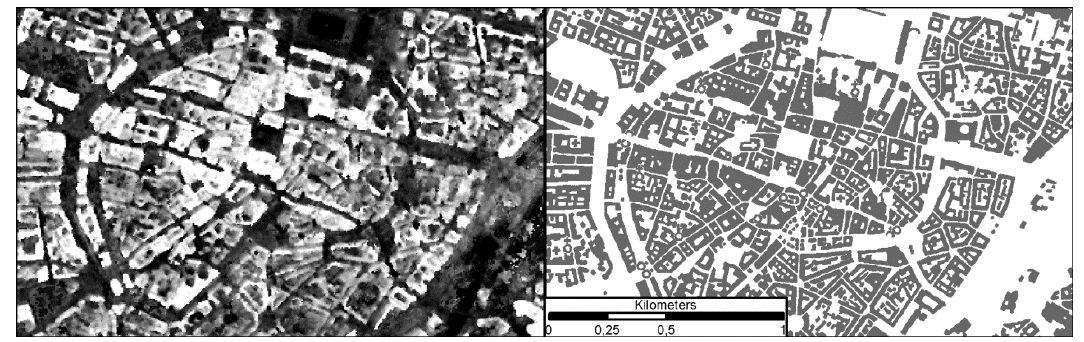
Figure 2. Spatial data input for the generation of the 3D building models using the example of the center of the Munich city region; left: normalized digital surface model; right: extracted building footprint objects from the topographic map DTK25-V. Topographic map: © GeoBasis-DE/BKG (2010), cf. [55].